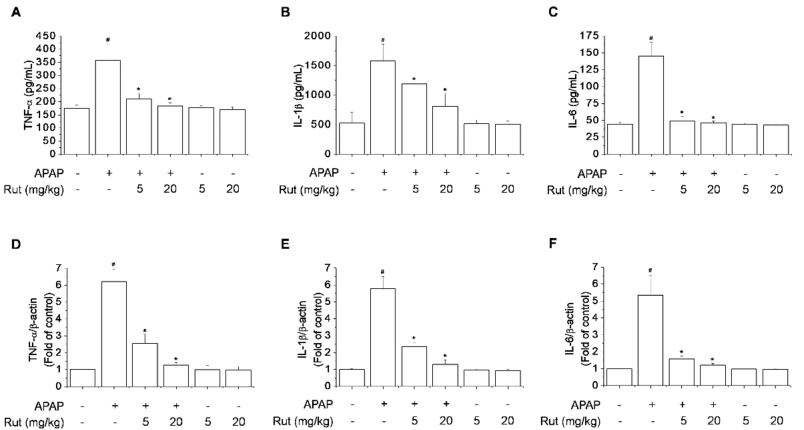
Figure 3. Protective effect of Rut on APAP-induced proinflammatory cytokines in mice. The mRNA expression of TNF- α ( A ), IL-1 β ( B ), and IL-6 ( C ) was determined using real-time PCR and the protein levels of TNF- α ( D ), IL-1 β ( E ), and IL-6 ( F ) using ELISA. Results are indicated as means ± SD ( n = 10). # Significantly different from the control ( p < 0.05). * Significantly different from the APAP-treated group ( p <